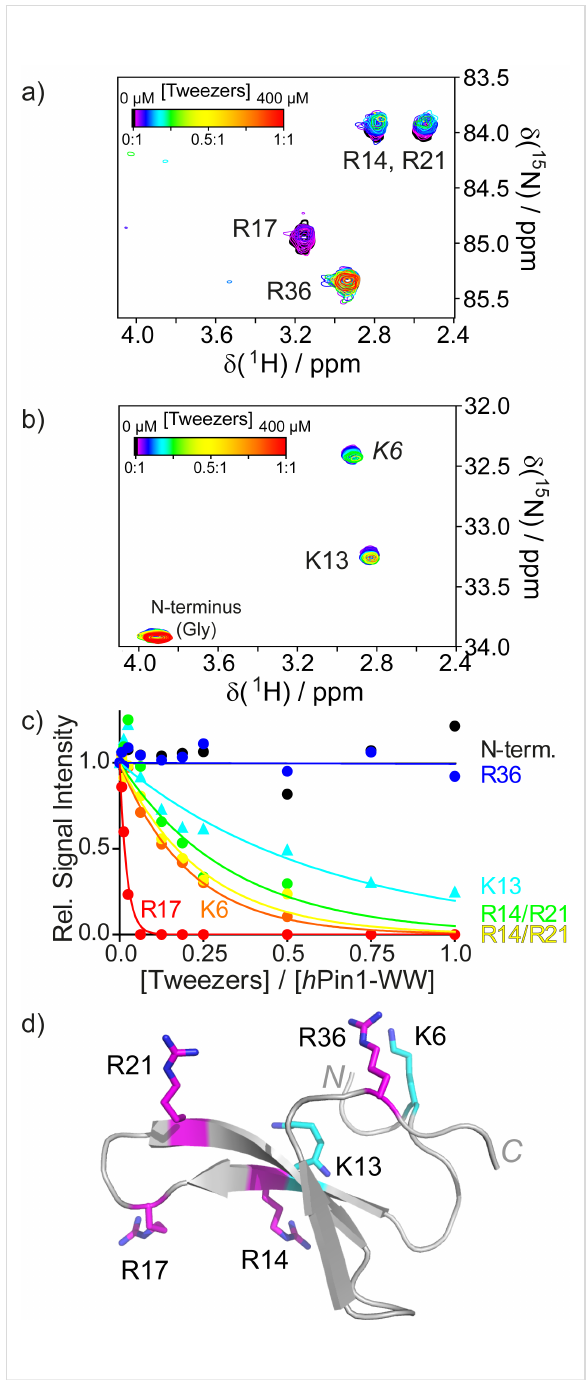
Figure 6: H2(C)N spectra specific for arginine (a) and lysine (b) residues of the h Pin1-WW domain at different tweezers concentra- tions (color-coded). The signals for R14 and R21 are both split and overlap. Upon tweezer binding, line broadening and thus reduced signal intensities are observed. (c) Plotting the relative signal intensi- ties for each signal as a function of tweezers concentration (given in equivalents) reveals a distinct binding order. R17 is the preferred binding site, while R36 and the N-terminus are not bound at all. (d) Structure of the h Pin1-WW domain with lysines highlighted in cyan and arginines highlighted in magenta. Reprinted (reproduced) with permis- sion from [80], copyright (2017) Wiley-VCH Verlag GmbH & Co.